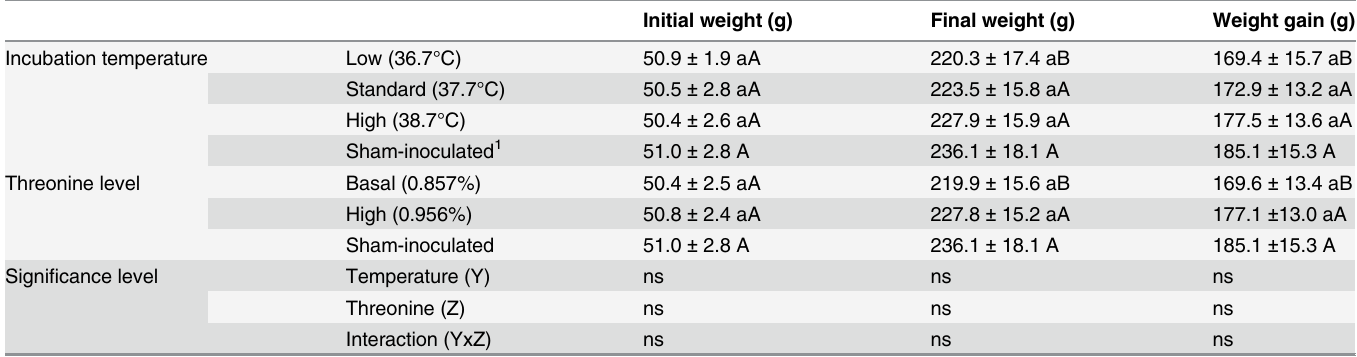
Table 2. Initial weight (1d), final weight (10d) and weight gain of chicks submitted to thermal manipulation during incubation and fed different thre- onine levels post-hatch (n = 10 per